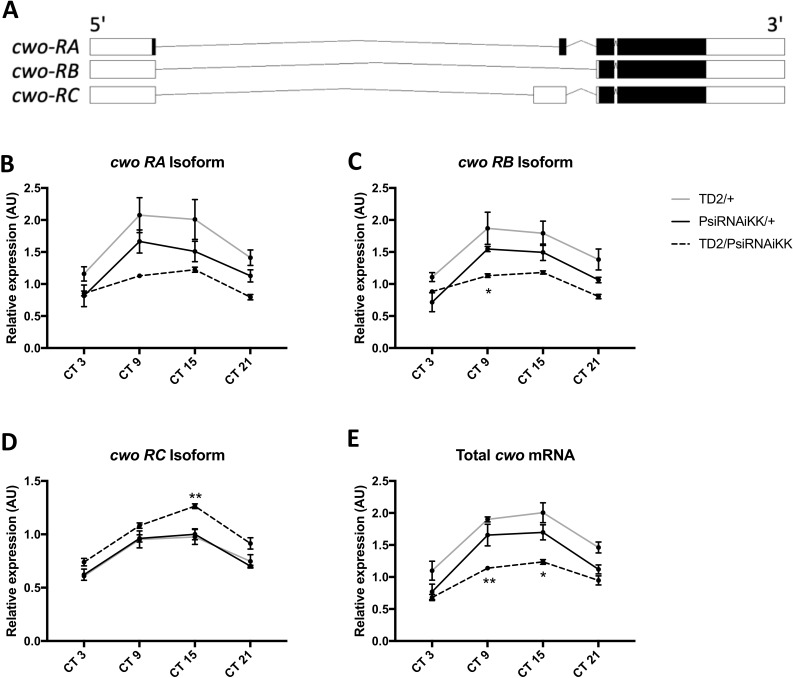
Knockdown of Psi affects the balance of cwo isoform expression.(A) Schematic of cwo isoforms. Adapted from Ensembl 94 (Zerbino et al., 2018). (B–D) Relative expression of cwo mRNA isoforms (normalized to the average of all Psi knockdown time points) in heads on the y axis measured by qPCR. (E) Relative expression of total cwo mRNA on the y axis. (B–E) Circadian time (CT) on the x axis. Error bars represent SEM. Gray line: driver control. Black line: RNAi control. Dashed line: Psi knockdown. Driver control, N = 3. RNAi control, N = 4. Psi knockdown, N = 6 (3 technical replicates per sample). Both driver and RNAi control compared to Psi knockdown, two-way ANOVA followed by Tukey’s multiple comparison test: *p<0.05, **p<0.01.Figure 3—figure supplement 1—source data 1.cwo qPCR data.Figure 3—figure supplement 1—source data 2.Figure statistics – Figure 3—figure supplement 1.